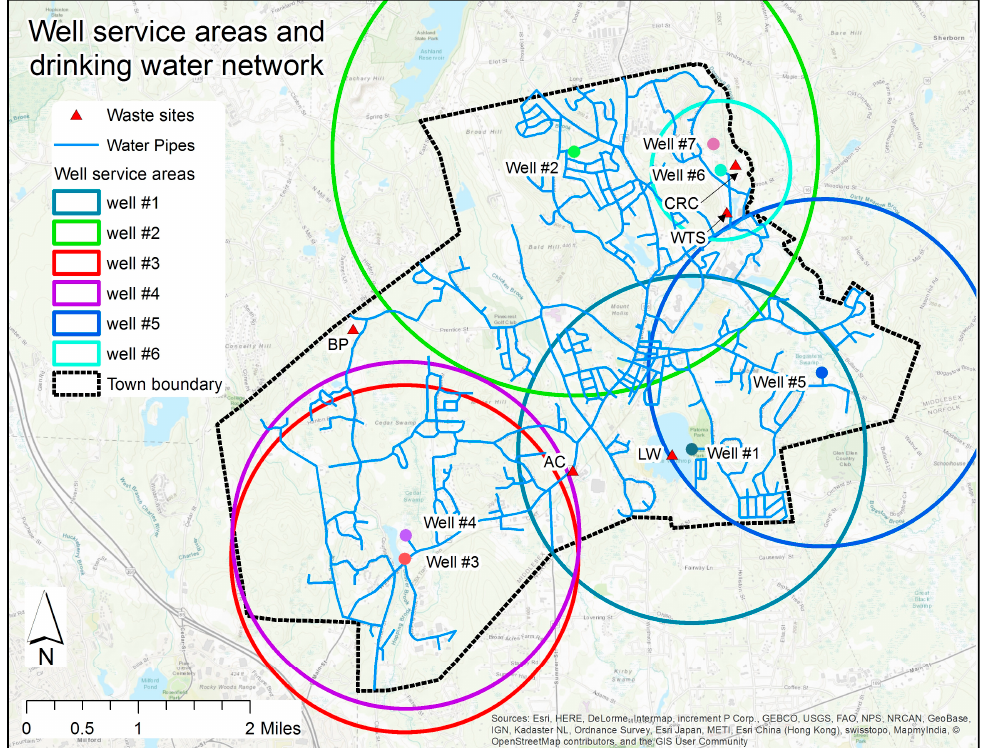
Figure 4. Drinking water network and estimated well services areas in Holliston. The service areas are homes served by the pipes that lie within each circle: the total dynamic head (TDH) that the reference pump can achieve is calculated based on the actual pipe network that lies within the circle. Note: The service areas for Well #2 and #6 do not overlap; #2 is able to serve low-elevation areas within the green circle only, while #6 serves high-elevation areas. The small area outside the circles (i.e., around BP) suggests that the model slightly underestimates service areas for Wells #2 and/or #4. Data sources: Bureau of Geographic Information (MassGIS), Commonwealth of